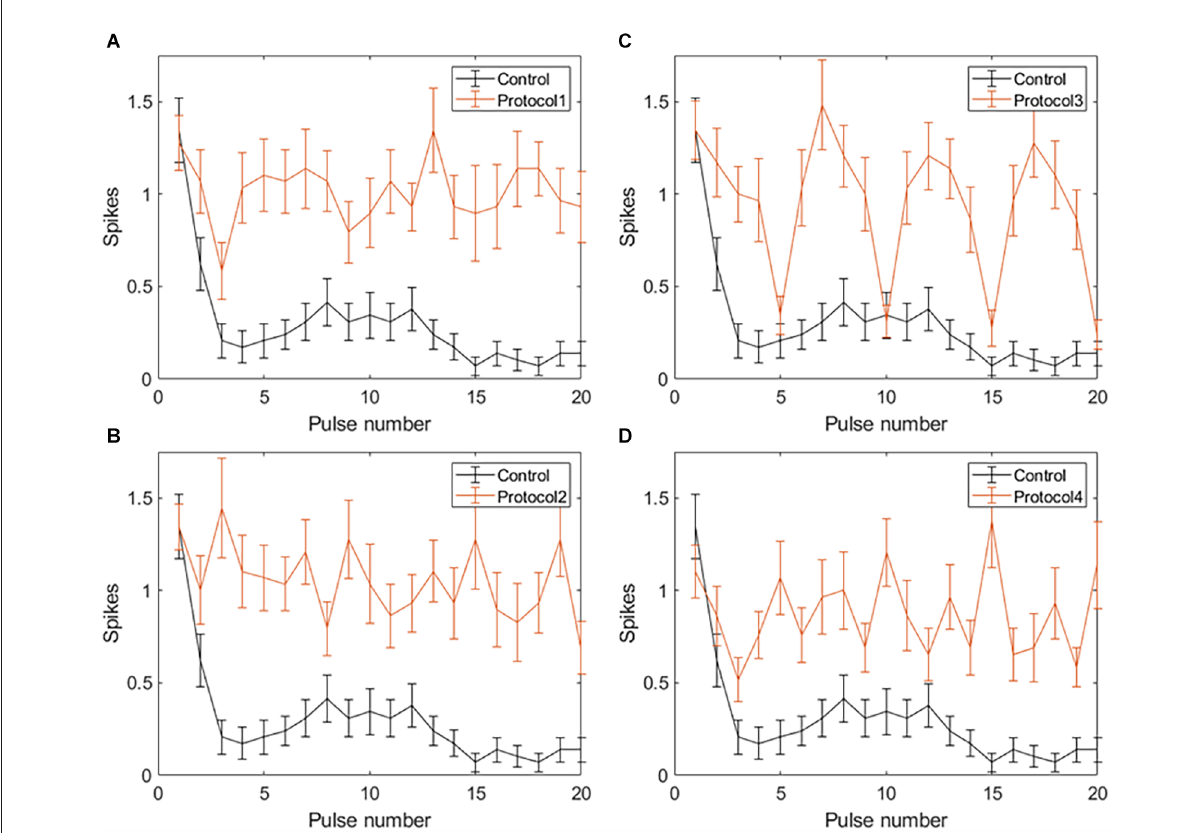
FIGURE6 Spiking activity of RGCs in response to VPCE pulse trains and control pulse train at 20 Hz. Number of evoked spikes counted in 5 ms bins after the onset of each pulse is plotted against the pulse number ( n = 29). The pulse sequences in Table 1 , Supplementary Tables S1, S2, and S3 are repeated to create a train of 20 pulses. Spiking activity in response to (A) Protocol 1: pulse width varies and charge per phase is kept constant. (B) Protocol 2: pulse width varies and charge per phase is calculated based on strength-duration curve. (C) Protocol 3: all pulse parameters vary and the charge per phase is kept constant. (D) Protocol 4: all pulse parameters vary and charge per phase is calculated based on strength-duration curve.